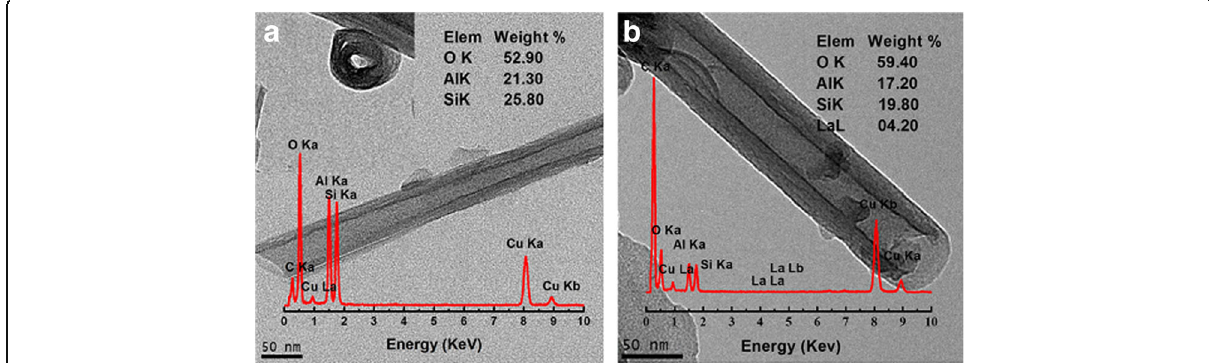
Fig. 1 TEM images of a HNT and b La-HNT